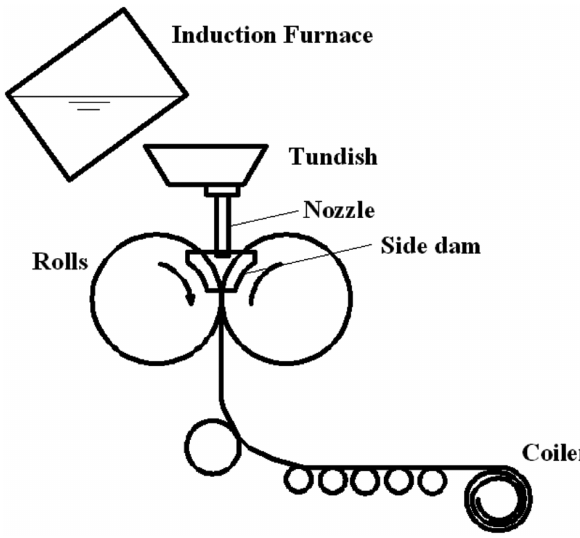
Figure 1: Schematic drawing of a lab-scale twin roll strip caster.